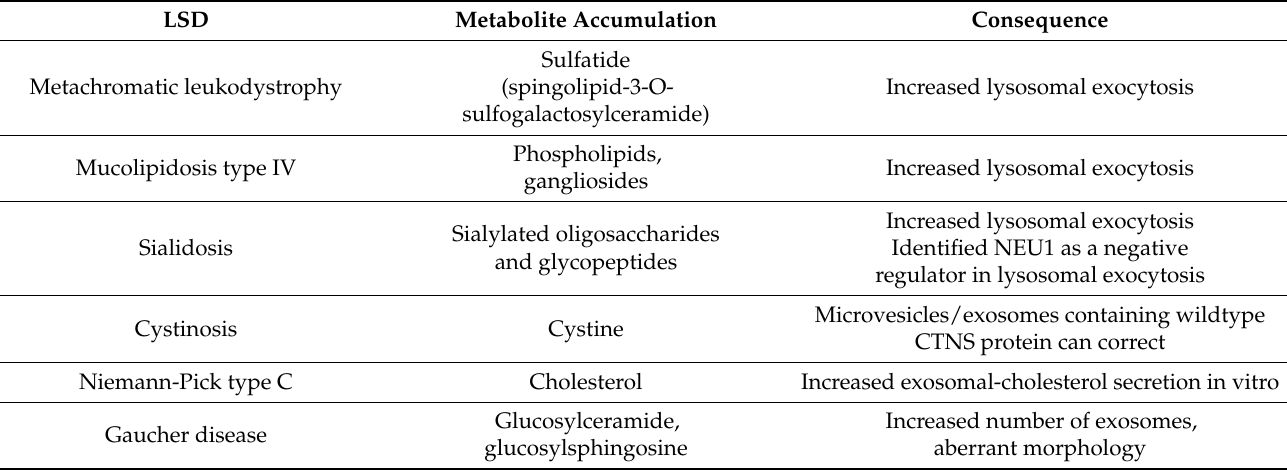
Table 1. Selected Lysosomal Storage Disorders